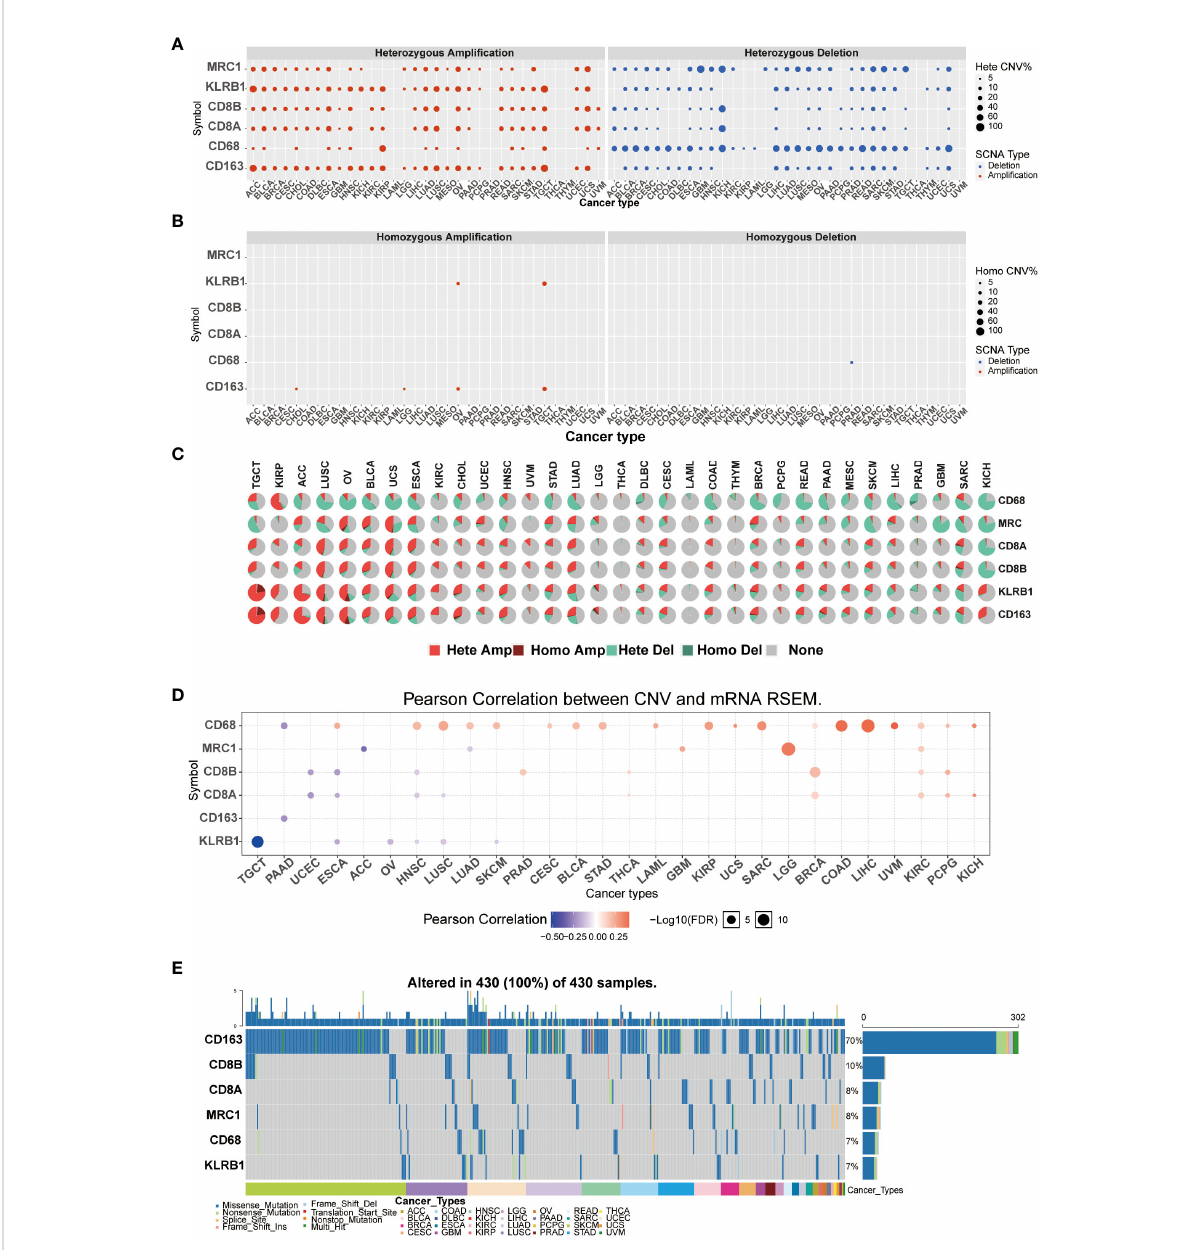
FIGURE 4 CNVs and SNVs were performed using the GSCALite platform. Heterozygous CNV of CD161 and T cells and macrophages (A) . homozygous CNV of CD161 and T cells and macrophages (B) . Pan-cancer analysis of heterozygous/homozygous CNVsof CD161 and marker genes of T cells and macrophages (C) . Hete Amp: heterozygous ampli fi cation; Hete Del: heterozygous deletion; Homo Amp: homozygous ampli fi cation; Homo Del: homozygous deletion; None: no CNV. The correlation between CNVs and mRNA expression levels of CD161 and marker genes of T cells and macrophages was analyzed in a pan-cancer context (D) . SNV frequency of CD161 and marker genes of T cells and macrophages. The gray vertical bars in the graph represent patients (E) . The top and side column diagrams indicate the number of variants per sample or in each